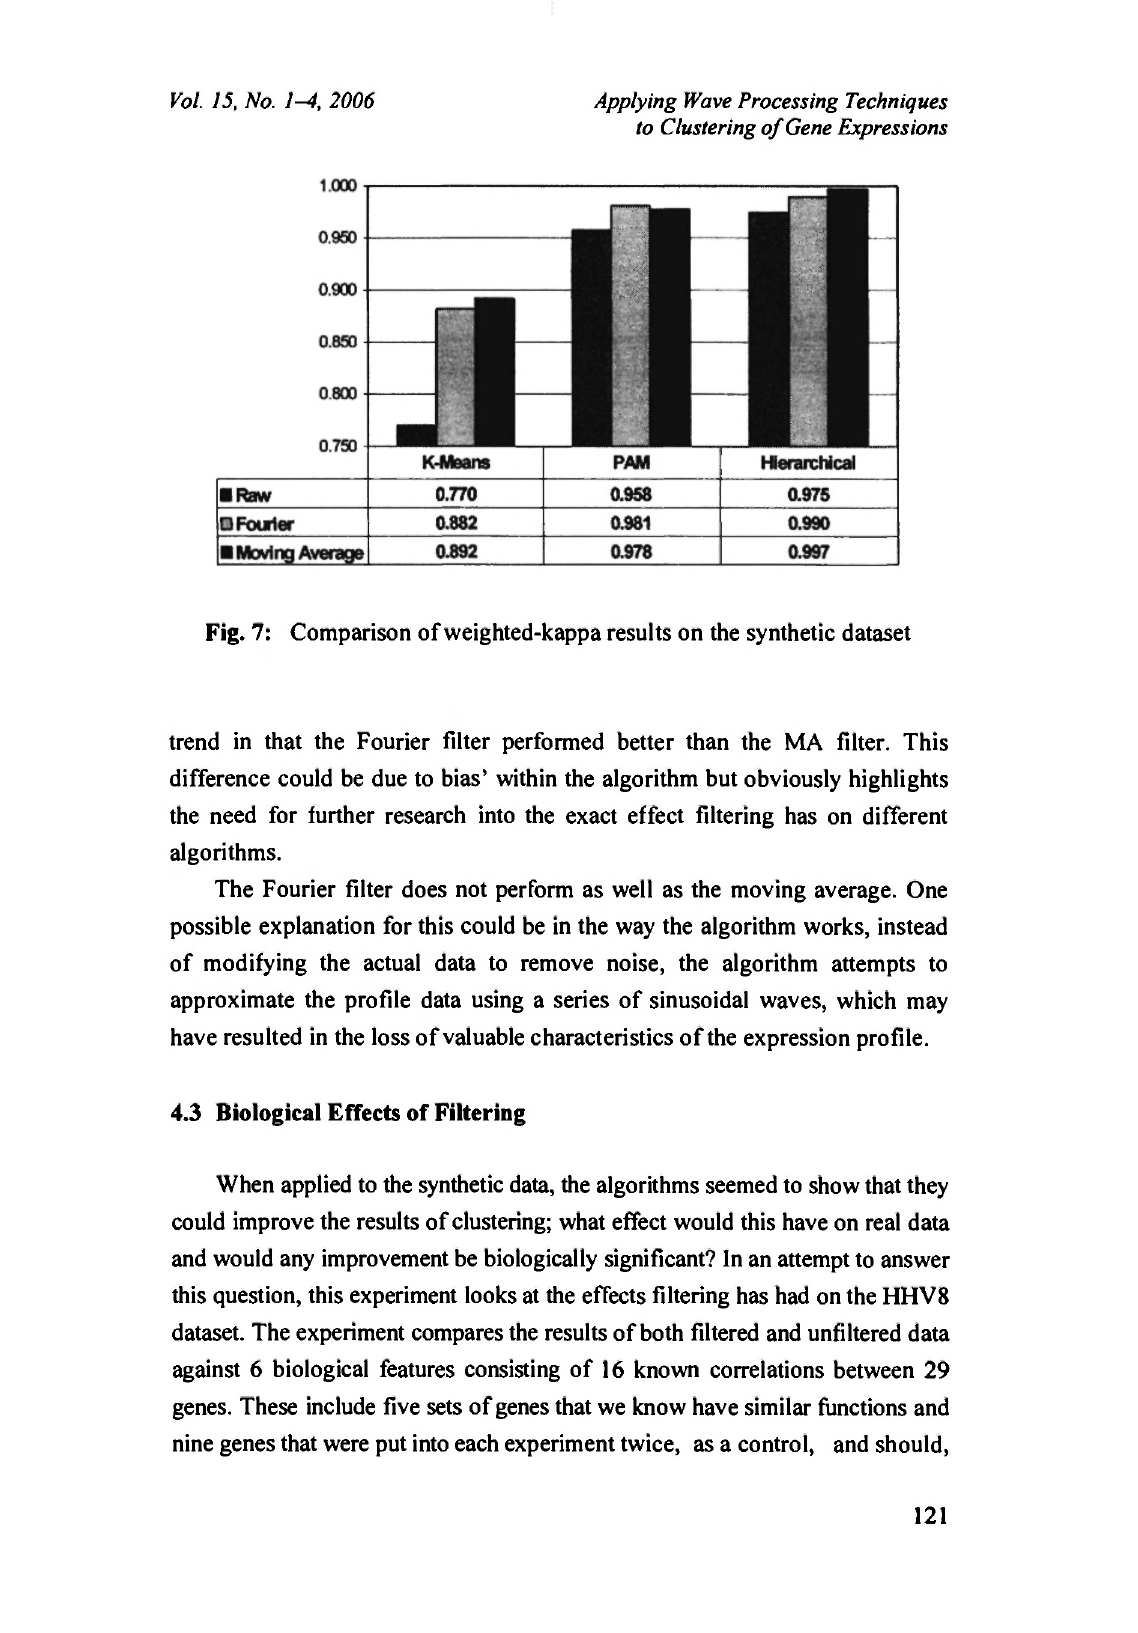
Fig. 7: Comparison of weighted-kappa results on the synthetic dataset